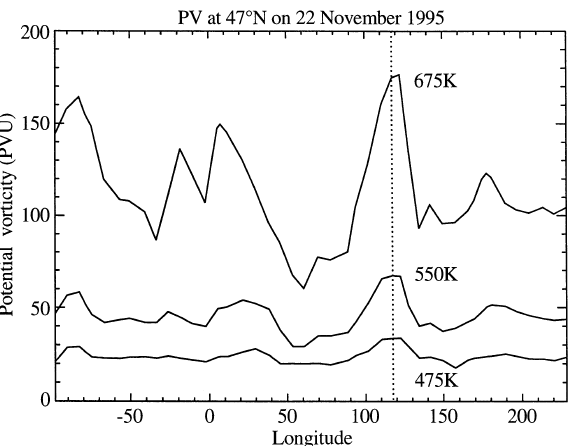
Fig. 9. Potential vorticity on November 22, 1995 at 47 (cid:14) N at three potential temperature surfaces against longitude. Dotted line indicates the location of the HALOE observation inside the vortex. Potential vorticity is derived from UK-Meteorological O(cid:129)ce (UKMO) meteorological analyses